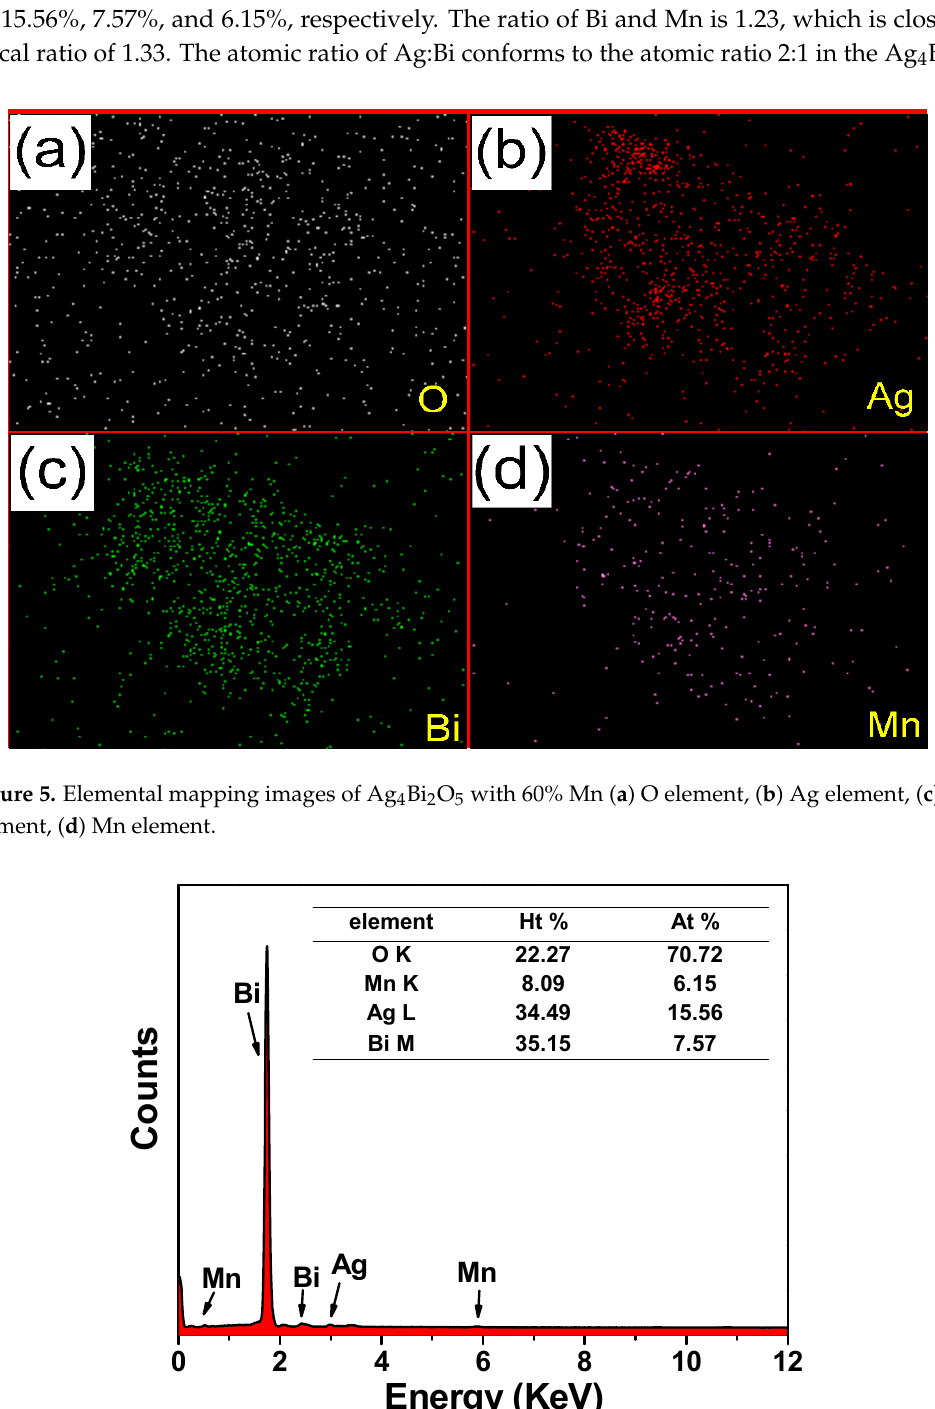
Figure 4. ( a ) Transmission electron microscopy (TEM) image of Ag 4 Bi 2 O 5 with 60% Mn, ( b ) high ‐ resolution transmission electron microscopy (HRTEM) image of Ag 4 Bi 2 O 5 with 60% Mn.